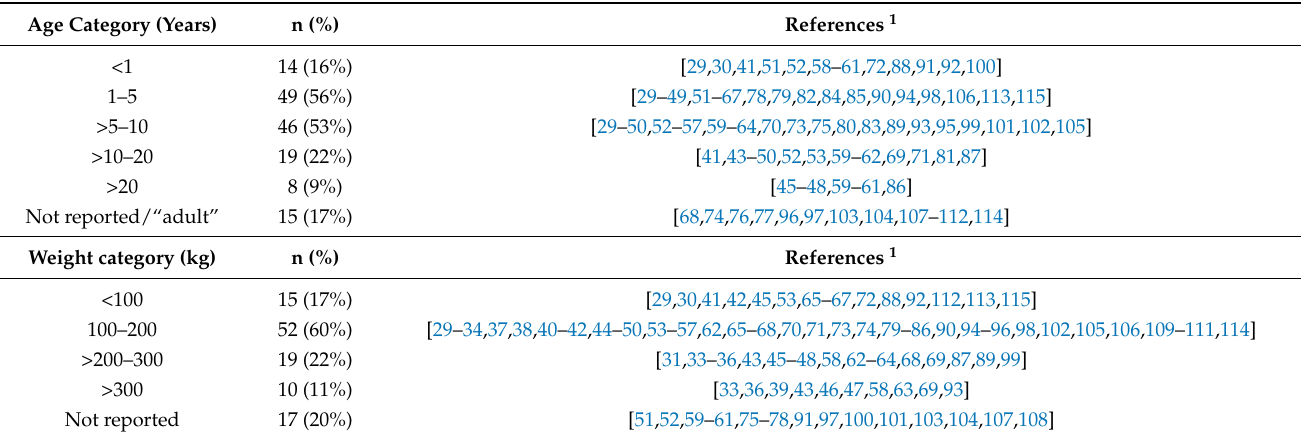
Table 4. Age and weight categories (n =